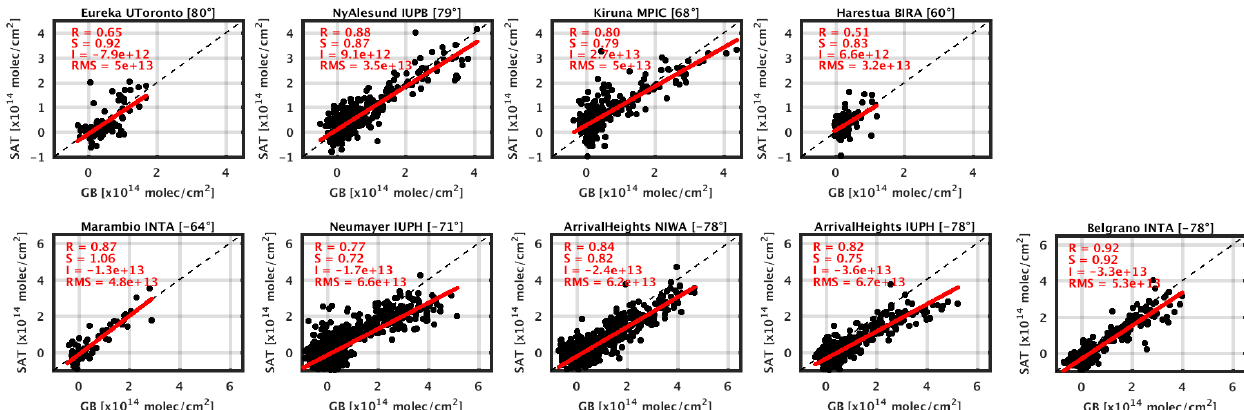
Figure 11. Scatter plot of GOME-2A OClO slant column data co-located with ground-based measurements at each station.